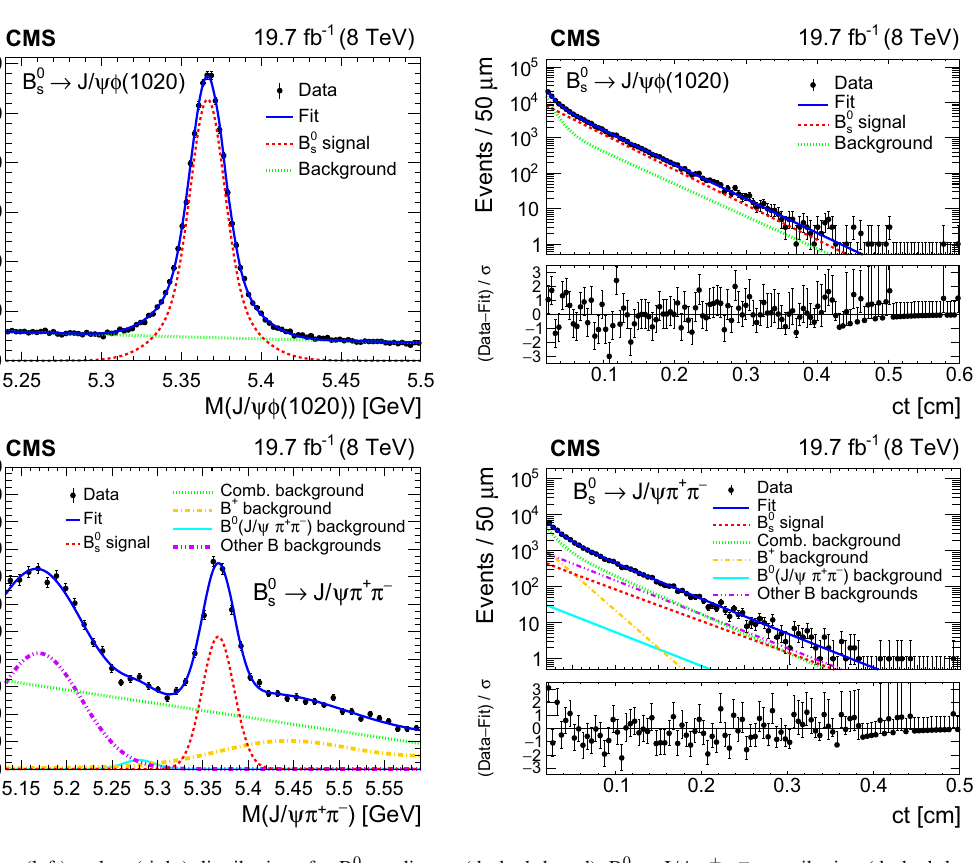
samples. Varied ct bin widths are used to ensure a similar signal yield among the bins. statistical uncertainty in the B + c The bin edges are defined by requiring a relative statistical uncertainty of 12% or better in each bin. The same binning and B + meson is used for the B + ct distribution. The B + c yields are shown versus ct in the left plot of Fig. 6, where the number of signal events is normalized by the bin width. Effi- ciencies are obtained from the MC samples and are defined as the ct distribution of the selected events after reconstruction divided by the ct distribution obtained from an exponential decay with the lifetime set to the same value used to generate each MC sample. The ratio of the two efficiency distributions, using the same binning scheme as for the data, is shown in the right plot of Fig. 6. to B + efficiency-corrected ct distribu- The ratio of the B + c tions, R / R ε , is shown in Fig. 7, along with the result of a fit to an exponential function. The fit returns ΔΓ = 1 . 24 ± 0 .